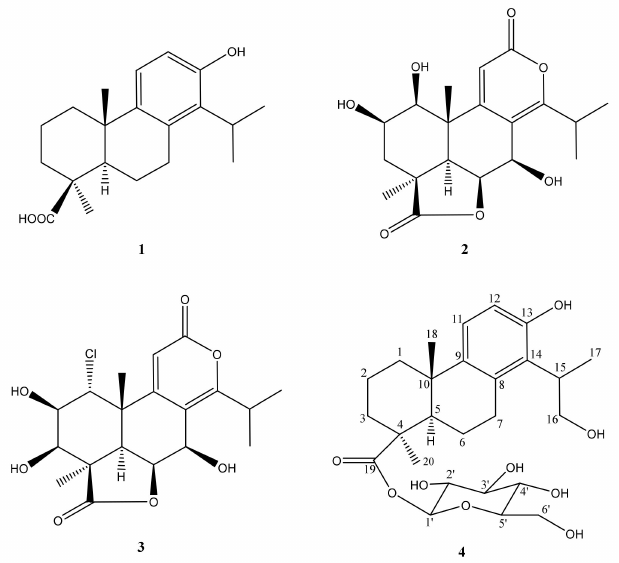
Figure 3. Structures of diterpenoids isolated from P. macrophyllus